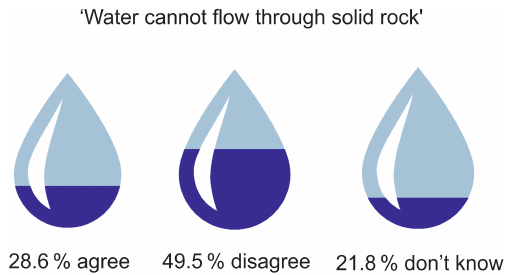
Figure 7. Attitudes of questionnaire respondents ( n = 220) to the statement “water cannot flow through solid